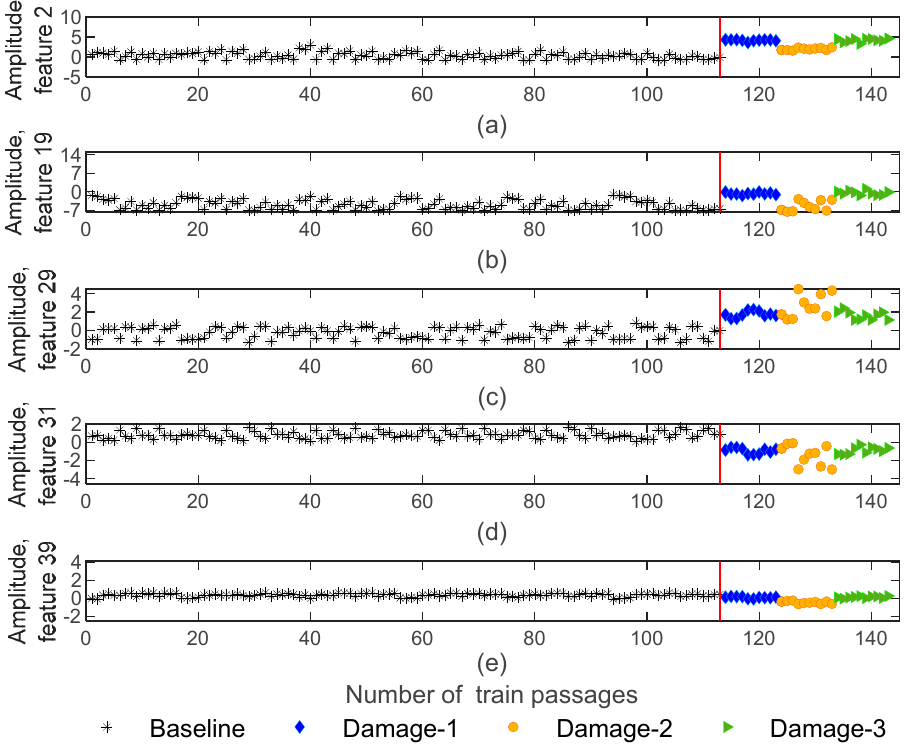
Figure 9. ARX—feature extraction for all 143 baseline and damage scenarios for accelerometer 3: ( a ) amplitude for feature 2, ( b ) amplitude for feature 19, ( c ) amplitude for feature 29, ( d ) amplitude for feature 31, ( e ) amplitude for feature 39.